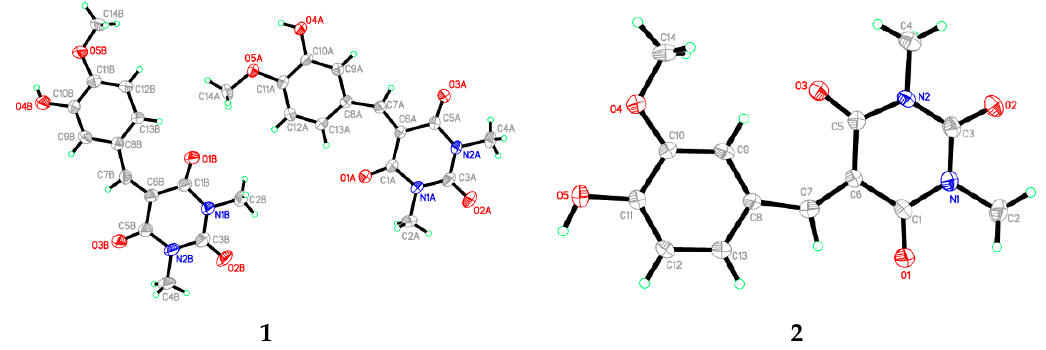
Figure 1. ORTEP (Oak Ridge Thermal-Ellipsoid Plot Program) of the synthesized compound 1 ( left ) and 2 ( right ). Displacement ellipsoids are plotted at the 40% probability level for non-H atoms.